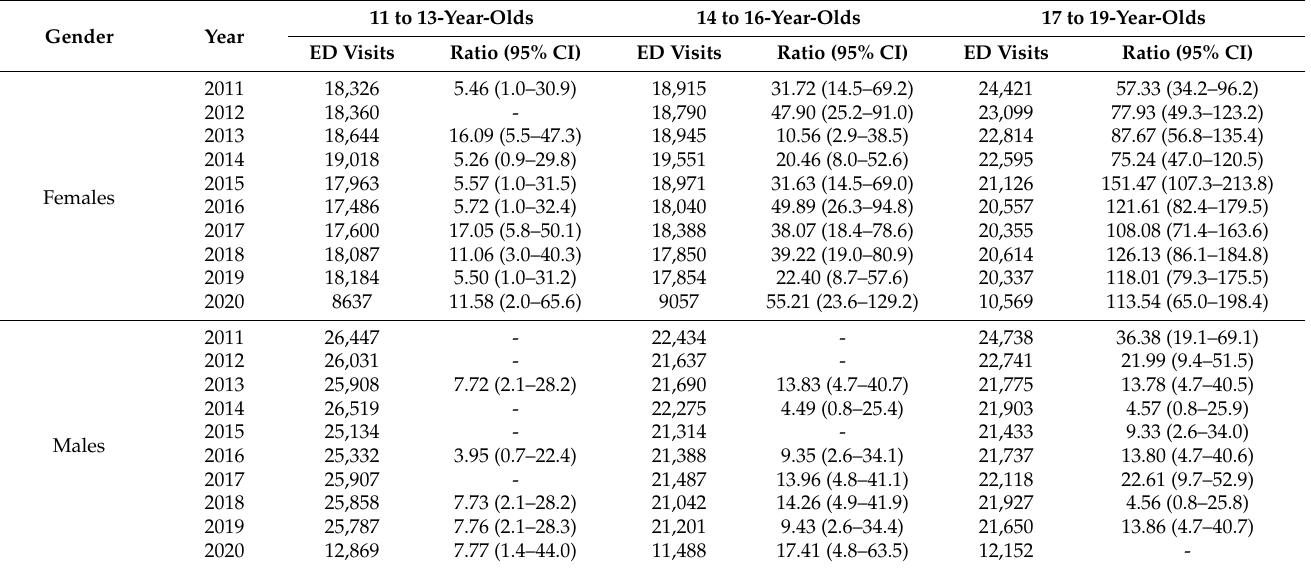
Table 2. Absolute year frequency of emergency department (ED) visits and age-specific sexually transmitted infection (STIs) ratio, per 100,000 ED visits, in 11 to 13, 14 to 16 and 17 to 19-year-old adolescents, by gender, years 2011 to 2020, Piedmont region,